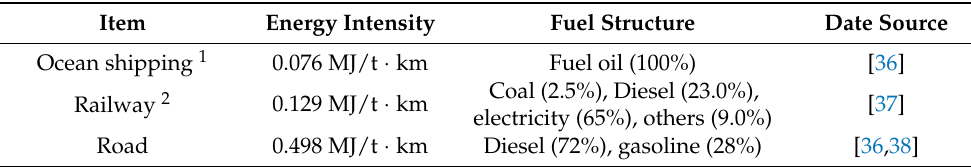
Table 2. Energy intensity and fuel structure of various transport